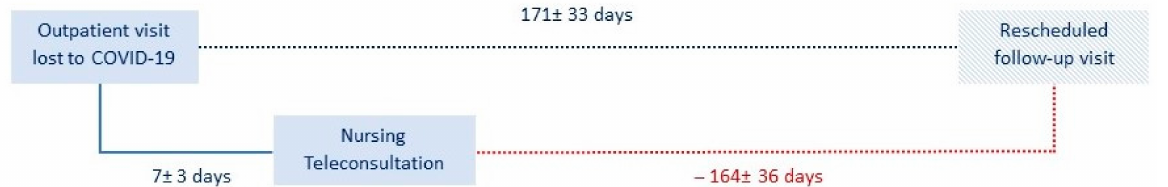
Figure 3. Time between the outpatient visit lost due to the COVID-19 lockdown, nursing teleconsultation and rescheduled in-person follow-up